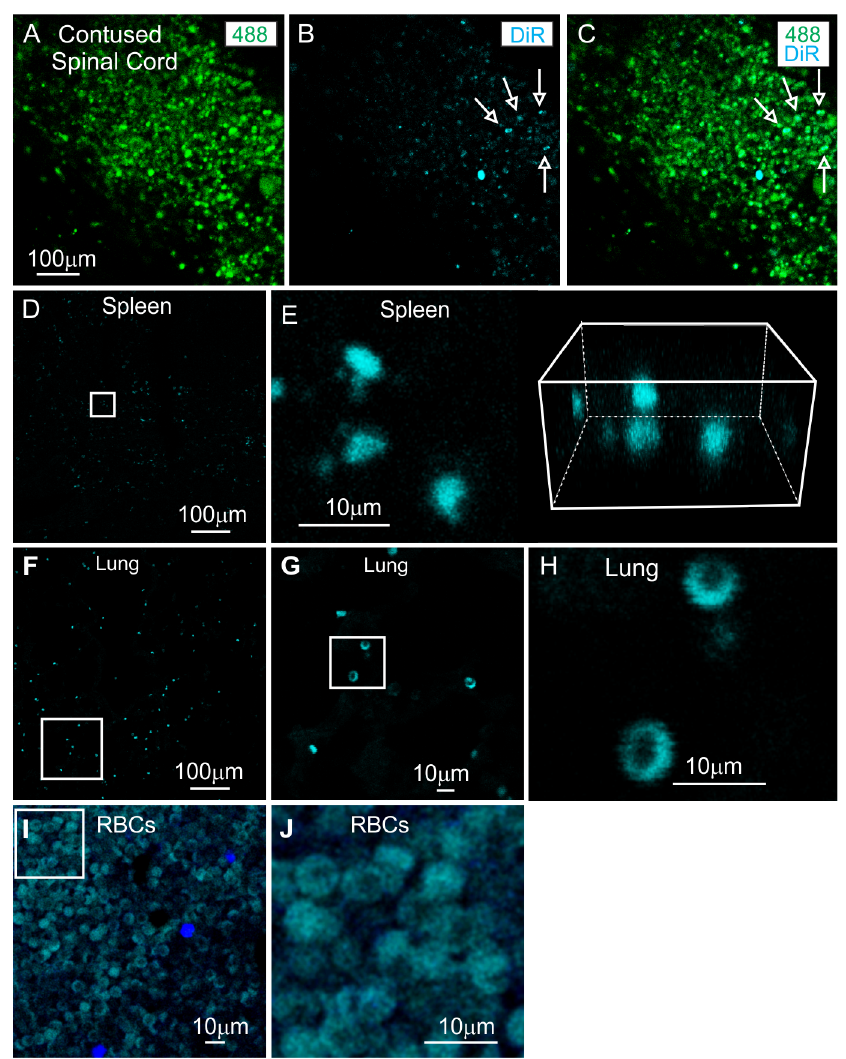
Fig 2. Exosome detection in situ. A-C: Two photon confocal micrographs of contused spinal cord 3 hours after IV infusion of DiR labeled exosomes showing the colocalization of regions of high endogenous 488 autofluorescence with 650nm DiR hotspots. D-H: Endogenous DiR wavelength in the spleen (D-E) and lungs (F-H) of contused animals with no exosome infusion. High magnification shows sizes and shapes of DiR hotspots in match those of red blood cells. I-J: Endogenous DiR wavelength fluorescence of paraformaldehyde fixed rat red blood cells isolated from peripheral blood. Scale bar in A indicates 100 μm and applies to A-C. Scale bars in D, F indicate 100 μm and applies to A-C. Scale bars in D, F indicate 100 micrographs of contused spinal cord 3 hours DiR